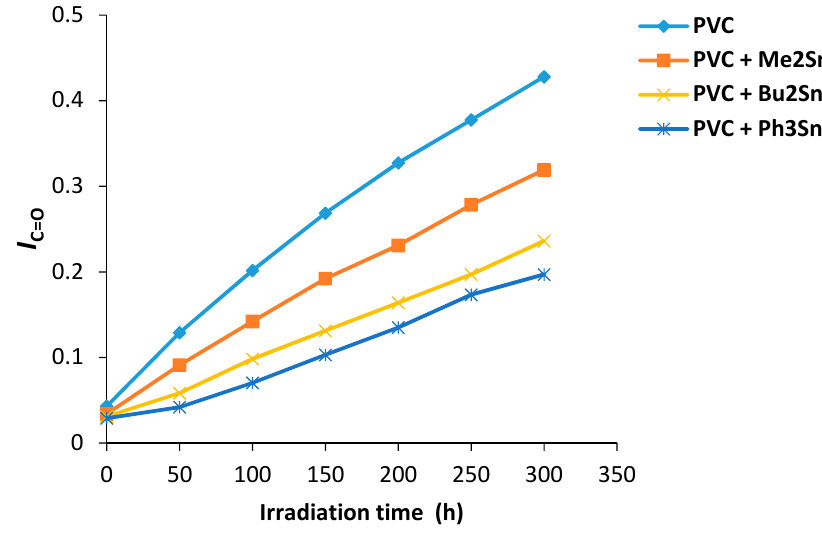
Figure 3. FTIR spectrum of PVC film containing Bu 2 SnL 2 complex after irradiation.